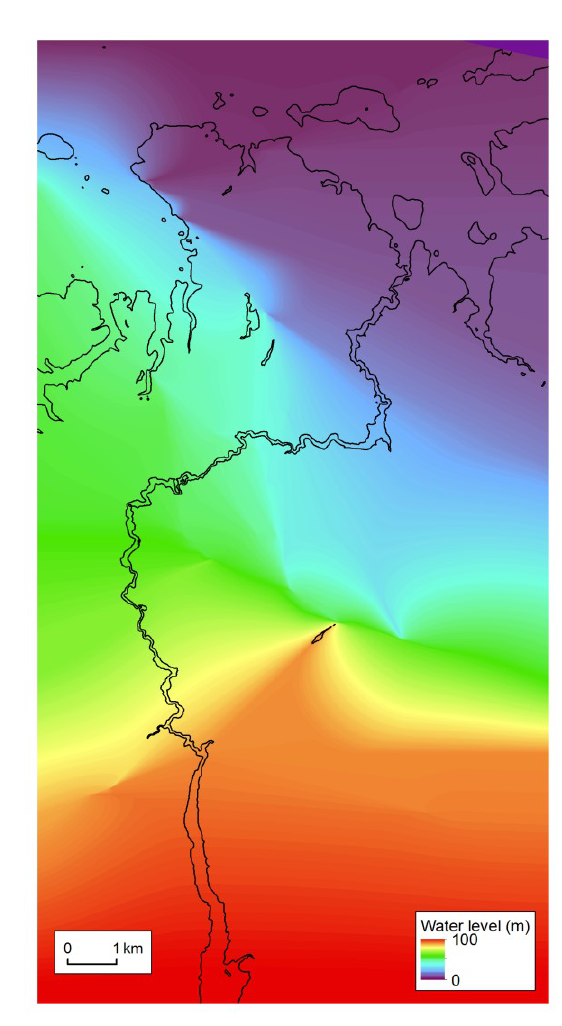
Figure 3. Interpolated water surface with delineated contour of the inundation